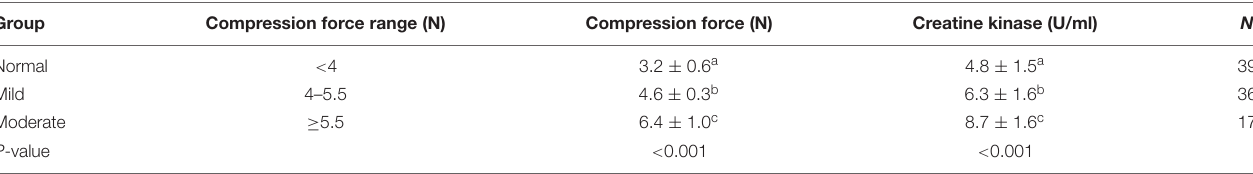
TABLE 4 | Serum creatine kinase (CK) level of different groups at 42 days of age in flock 1.